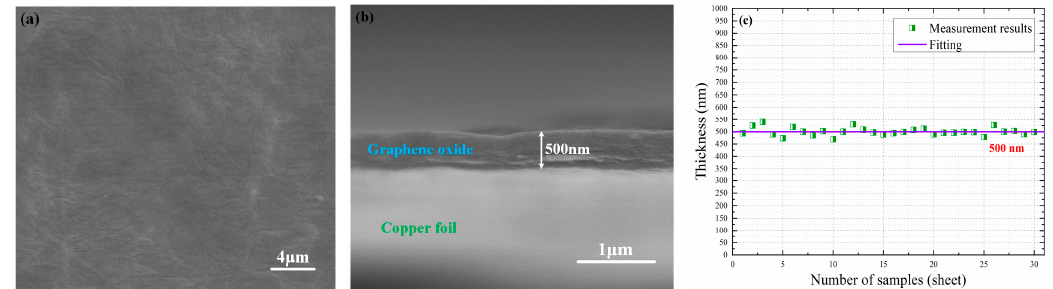
Figure 3. ( a ) Scanning electron microscope (SEM) image of the prepared GO film surface. ( b ) SEM image of the prepared GO film thickness. ( c ) Representative thickness values of 30 different GO films.